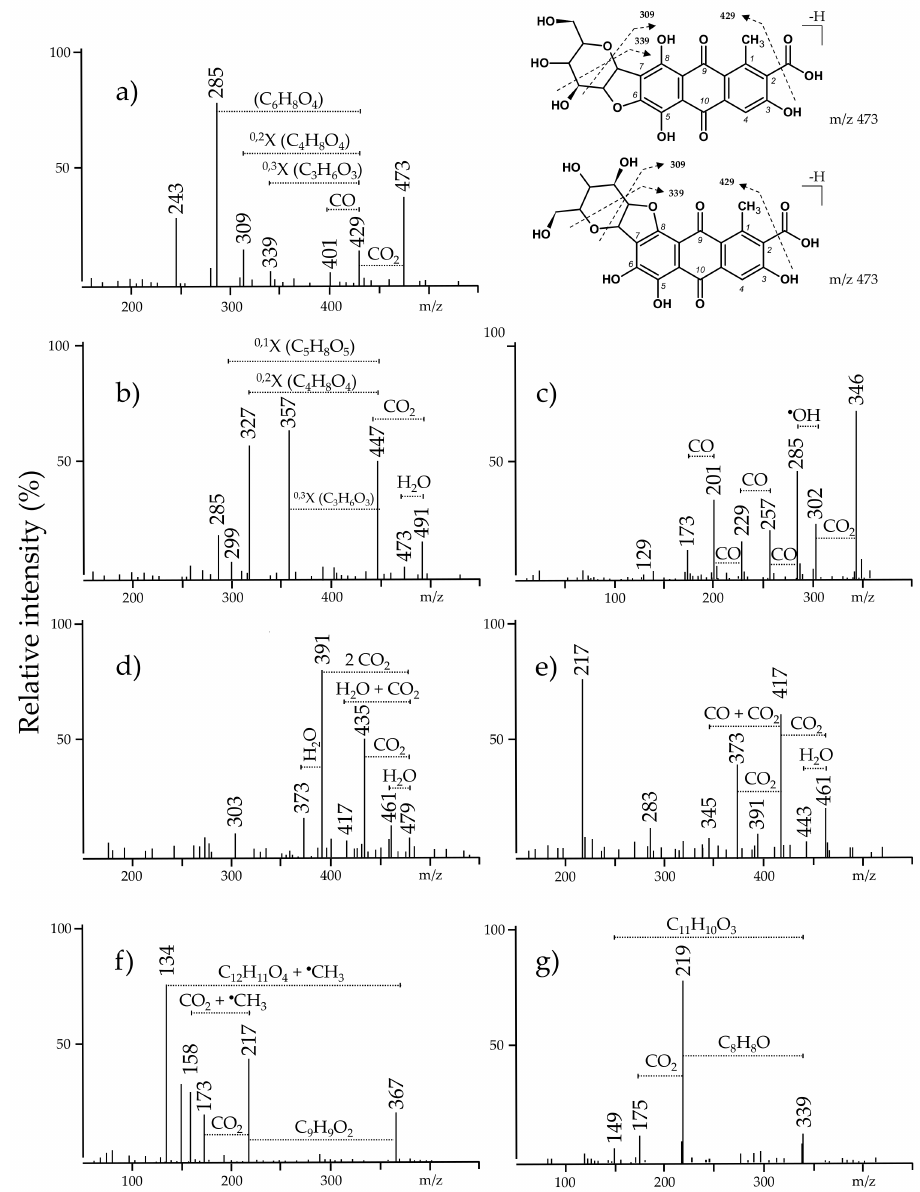
Figure 6. MS spectra acquired in negative ion mode and the proposed fragmentations of: ( a ) de- hydrated carminic, ( b ) carminic acid, ( c ) unidentified 346, ( d ) xantholaccaic acid B, ( e ) dehydrated xantholaccaic acid B, ( f ) curcumin, and ( g )